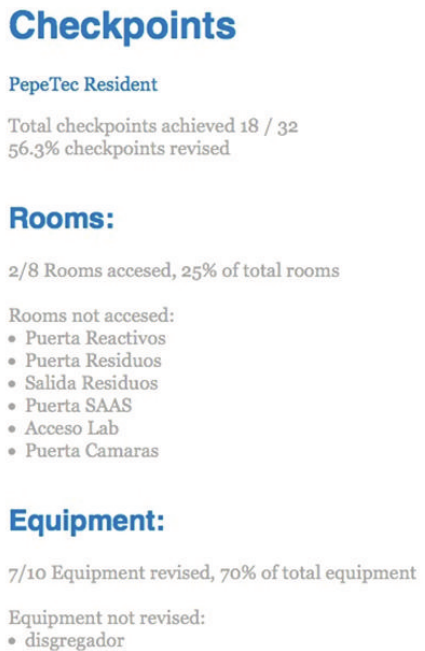
Figure 7: Search for checkpoints achieved by one